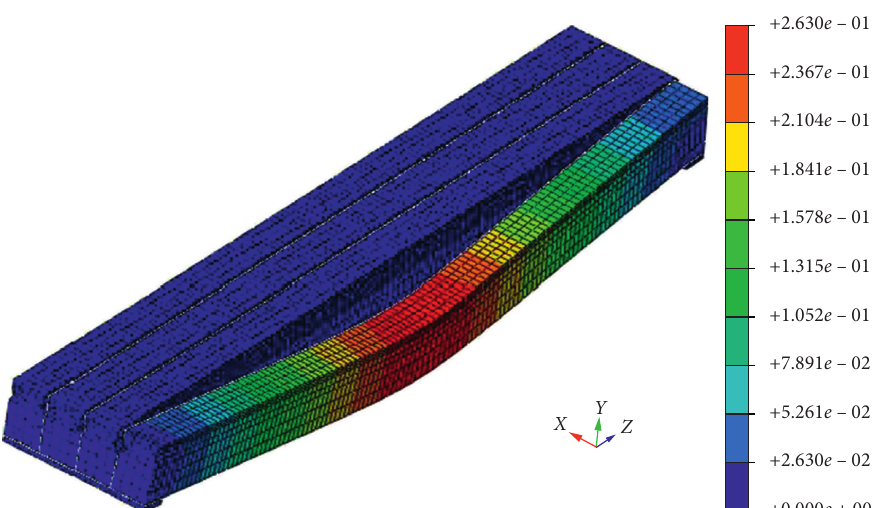
Figure 12: Failure mode of the model bridge under a concentrated load.